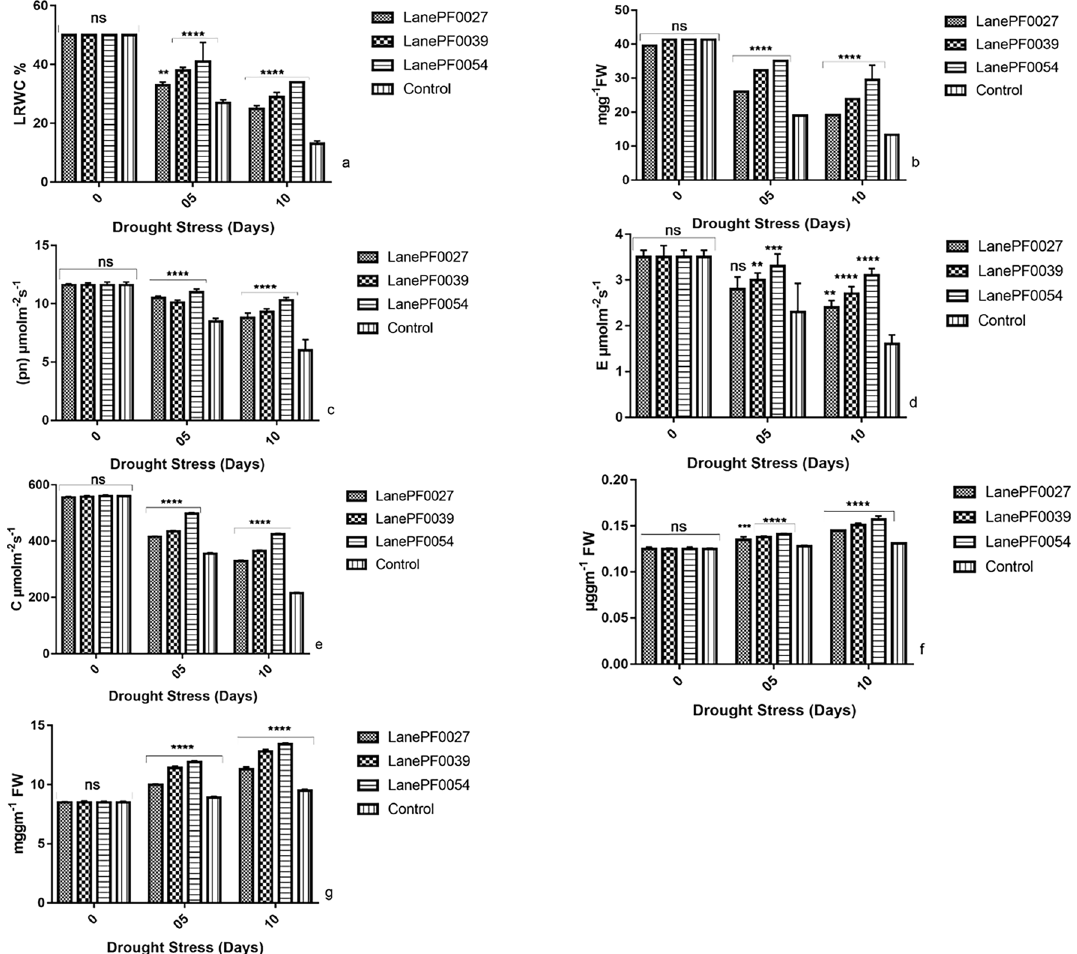
Figure 8. Effect of drought stress on physiological parameters of transgenic cotton plants with GaZnF gene. ( a ) Comparison of Leaf relative water content of transgenic and control plants, ( b ) Comparison of chlorophyll of transgenic and control plants, ( c ) Comparison of photosynthesis rate of transgenic and control plants, ( d ) Comparison of transpiration rate of transgenic and control plants, ( e ) Comparison of stomatal conductance of transgenic and control plants, ( f ) Comparison of proline content of transgenic and control plants, ( g ) Comparison of soluble sugar of transgenic and control plants. The means ± SD of three biological replicates are presented. Error bars represent the standard deviation of the mean. Above the bars ****, ***, ** represent significant and ns represent non-significant differences between transgenic and non-transgenic plants respectively at the P < 0.05 level according to LSD multiple range